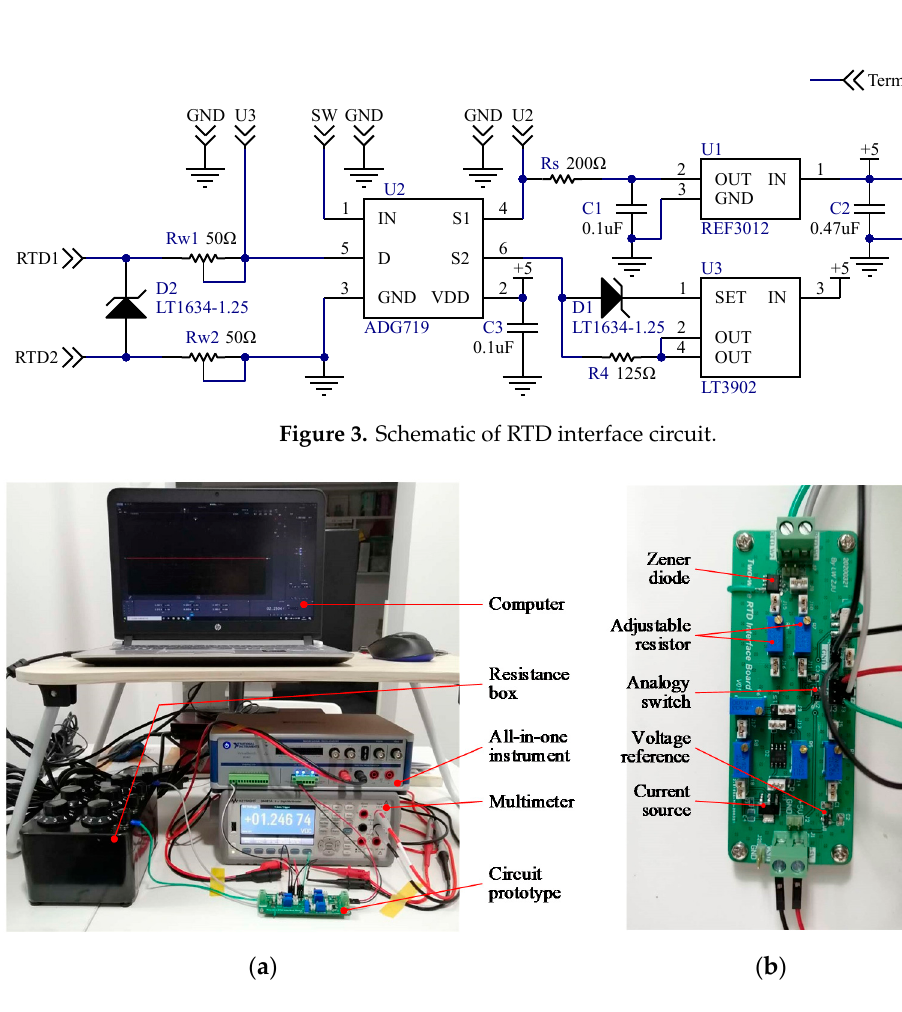
Figure 4. ( a ) General view of the experimental devices; ( b ) close-up shot of the circuit